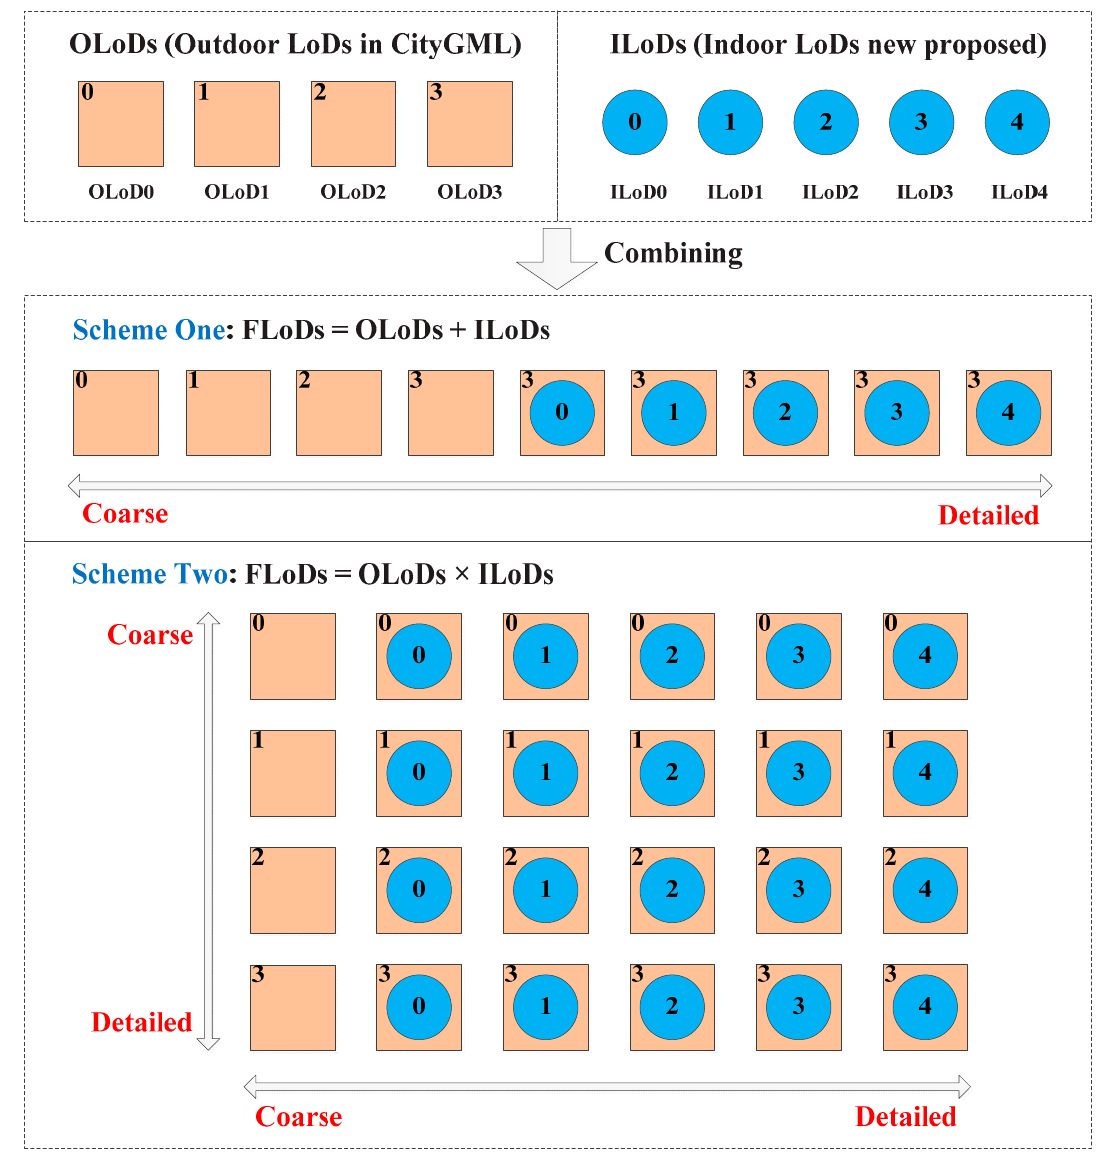
Figure 10. Two potential schemes of the connection between OLoDs and ILoDs.